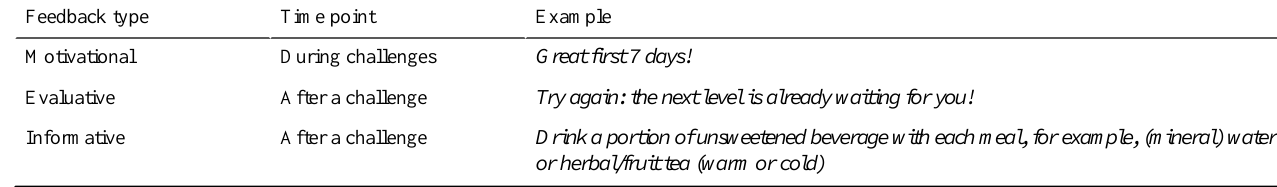
Table 6. Feedback examples.